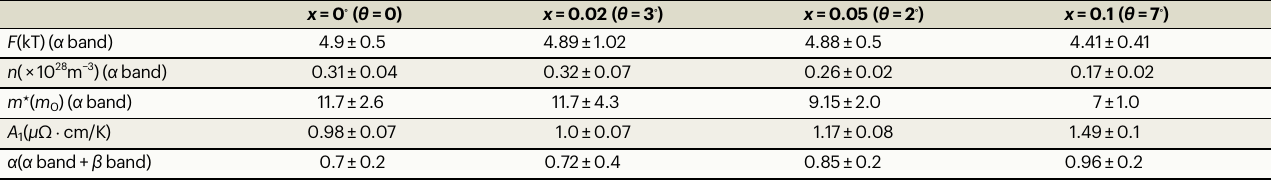
TheaverageddHvAfrequencies F ,carrierconcentration n ,andeffectivemasses m ⋆ ofthe α bandshownherearetakenfromref. 28 .Carrierconcentration n ofthe α -bandfor x =0.05isestimatedbya d -dimensionalFermivolumewith d =2.45,whileitisestimatedbyatwo-dimensionalFermivolumefor x =0, 0.02,inaccordancewiththeangulardependenceofthedHvAfrequenciesmeasuredin ref. 26 .Here, m 0 denotesthebareelectronmass,while α and A 1 areextractedfromthelinear-in-temperatureresistivityatzero fi eldfromref. 26 .Theerrorbarsof F , n ,and m ⋆ representthestandard deviation.Theerrorbarsof α and A 1 shownherearethesameasdescribedinFig.2.Notethatthe α coef fi cientshownherecontainsasub-leadingcontributionfromthe β